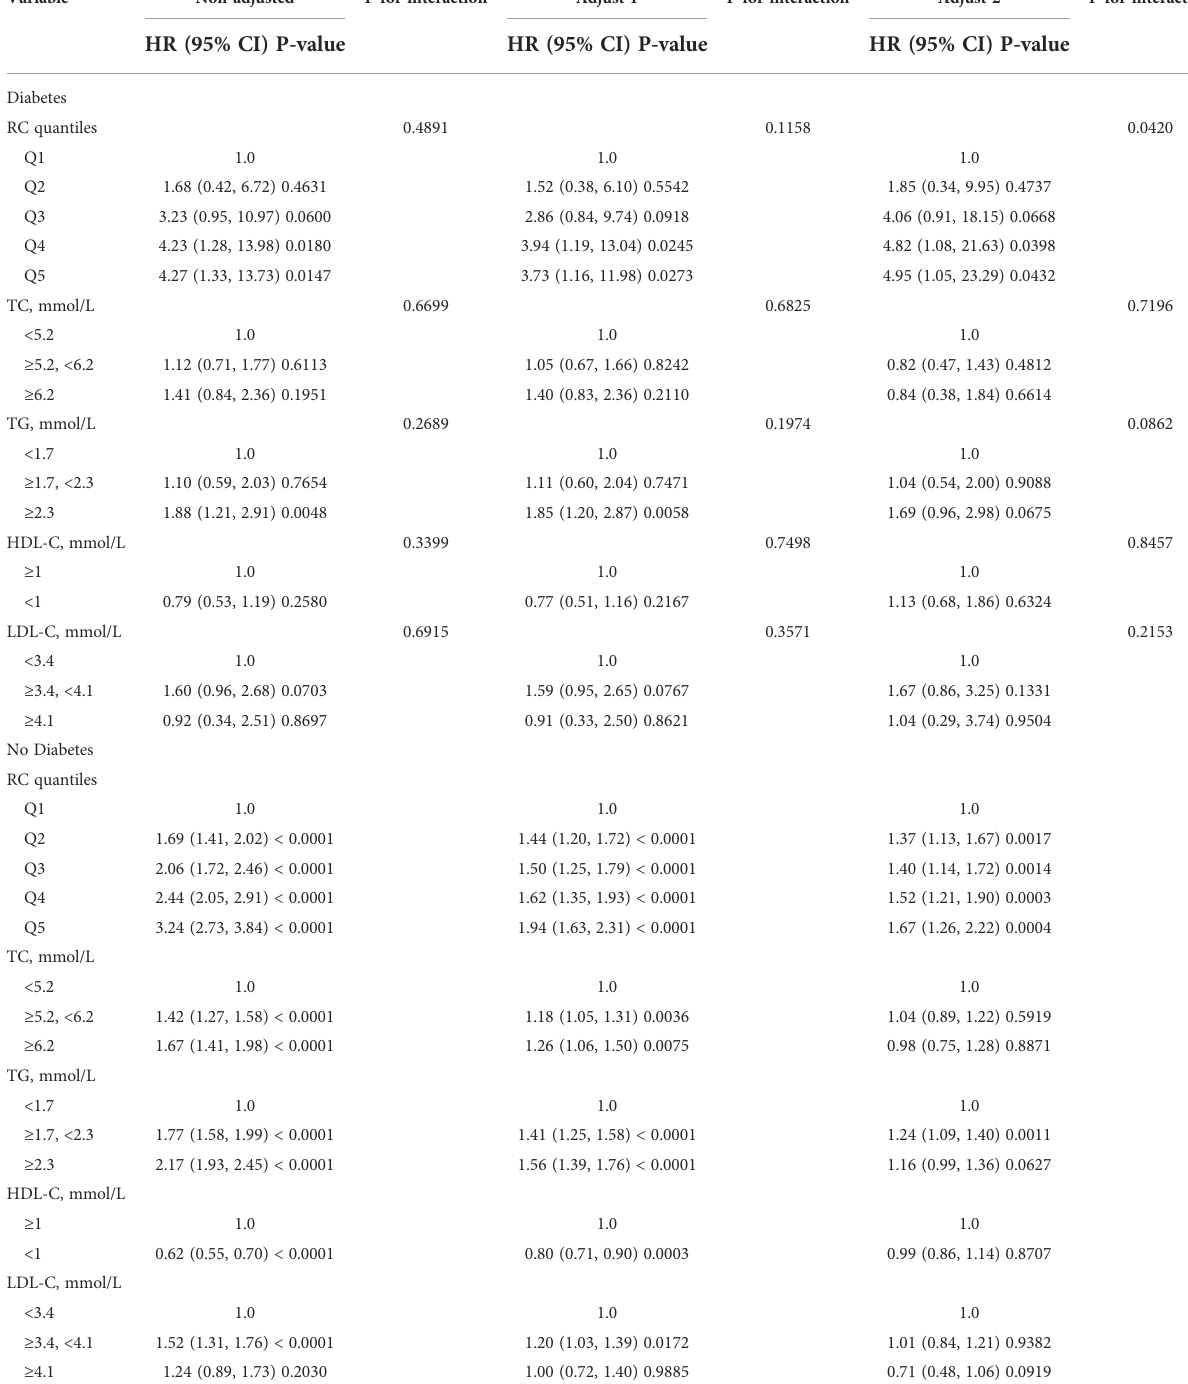
TABLE 3 Association of RC, lipid parameters with HTN incidence among participants with and without